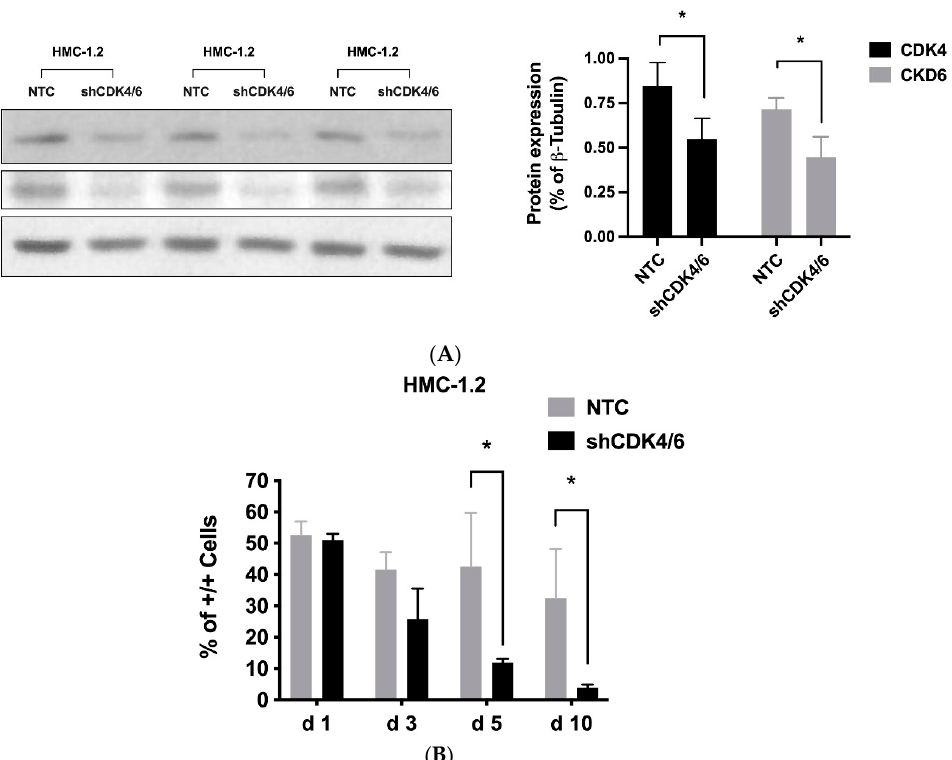
Figure 1. The CDK4/CDK6 pathway represents a therapeutic target in neoplastic MC. HMC-1.2 cells were simultaneously transfected with shRNA directed against CDK4 and CDK6 (shCDK4/6; both inducible with doxycycline) or with two non-targeting control shRNAs (NTC) labeled with GFP/RFP. ( A ): Transfected cells were selected by puromycin and induced with doxycycline for 72 h. Thereafter, knockdown of CDK4 and CDK6 was confirmed by western blotting in triplicate (left panel). Protein expression (as ratio of ß-tubulin) was determined by densitometric analysis. The mean protein expression was calculated for each condition (right panel). Asterisk (*): p <0.05. ( B ): After 72 h of doxycycline exposure, GFP+/RFP+ cells were FACS-sorted. FACS-sorted HMC-1.2 cells transfected with two non-targeting control shRNAs (NTC) or with shRNA directed against CDK4 and CDK6 (shCDK4/6) were mixed with non-transfected HMC-1.2 cells at a 1:1 ratio and cultured for 10 days. The percentage of GFP+/RFP+ cells (+/+) was monitored by flow cytometry on days 1, 3, 5, and 10. Asterisk (*): p < 0.05. Abbreviations: CDK, cyclin-dependent kinase; shRNA, short hairpin RNA; GFP, green fluorescent protein; RFP, red fluorescent protein.